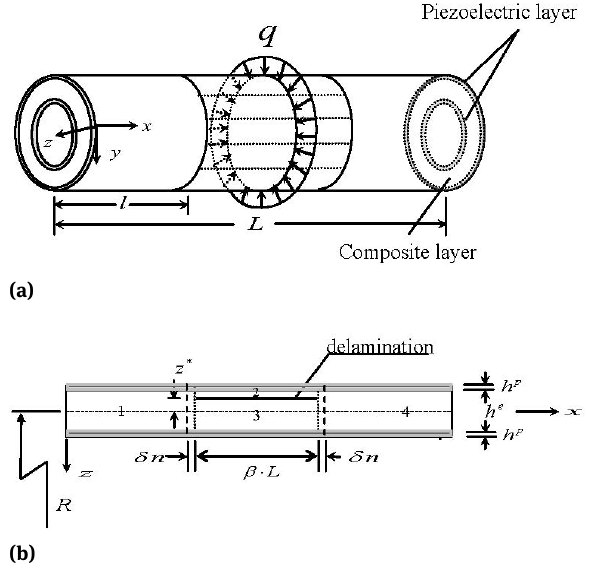
Figure 1. (a) Geometry of piezoelectric laminated shell with delami- nation (b) section of cylindrical